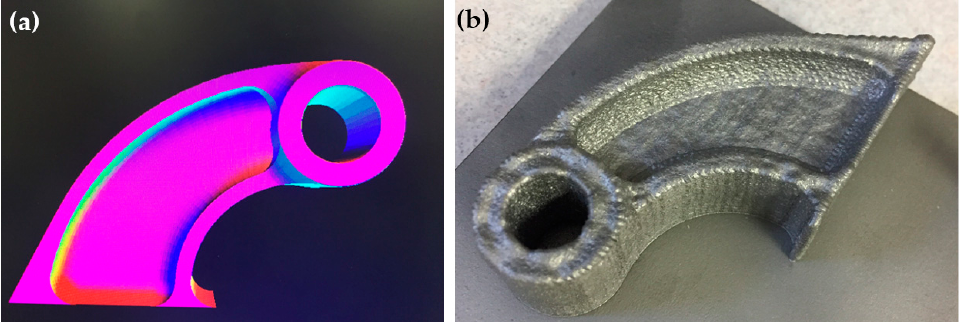
Figure 2. A fitting printed by LENS from Ti-6Al-4V alloy. ( a ) Upright design of the fitting. ( b ) The printed fitting after bead